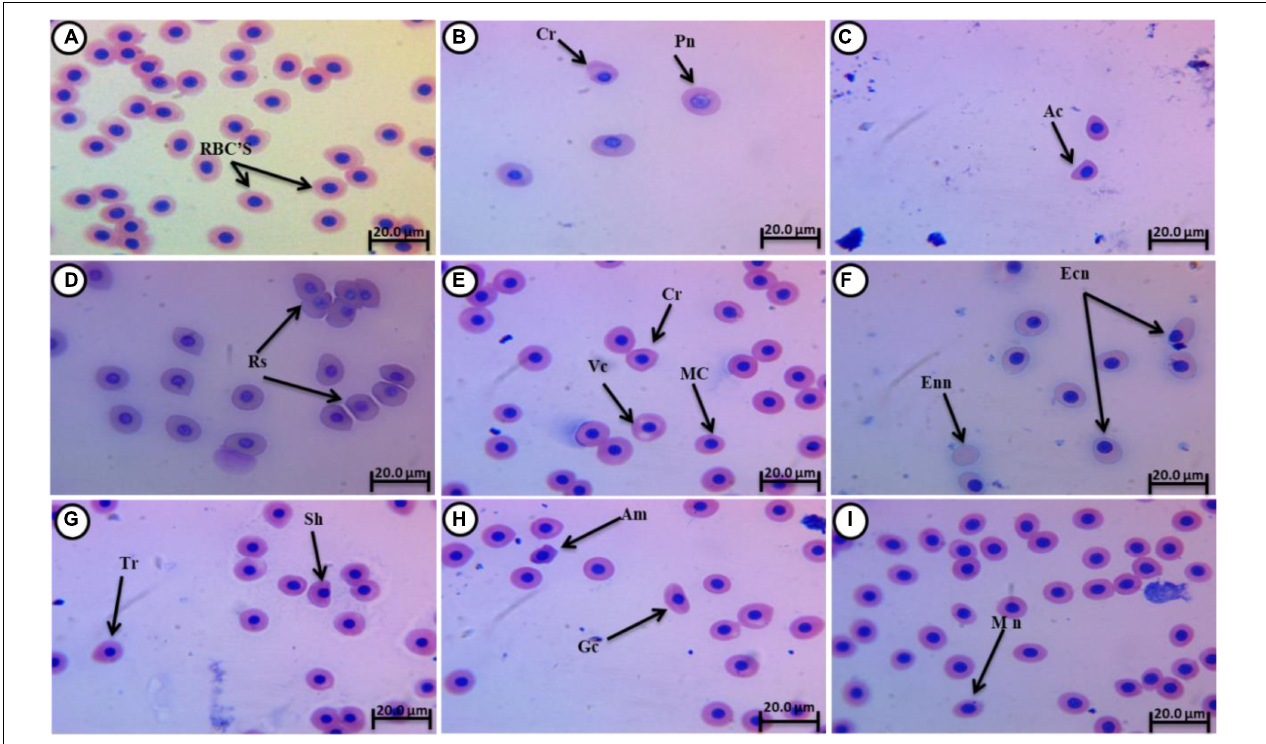
FIGURE 3 | Giemsa-stained blood smears from juvenile C. gariepinus , showing normal erythrocytes and (A) deformed erythrocytes (B–I) after exposure to 4-NP for 15 days. Tr, teardrop cell; Cr, crenated cell; Pn, pale nucleated cell; Rs, Redoulex-shaped cell; Ac, acanthocyte; Vc, vacuolated cell; Ecn, eccentric nucleus; Mn, micronucleated cell; Enn, enucleated cell; Am, amoeboid cell; Mac, macronucleated cell; Gc, genuine cell; and Sk, sickle cell. (Magnification = 1,000 × ).